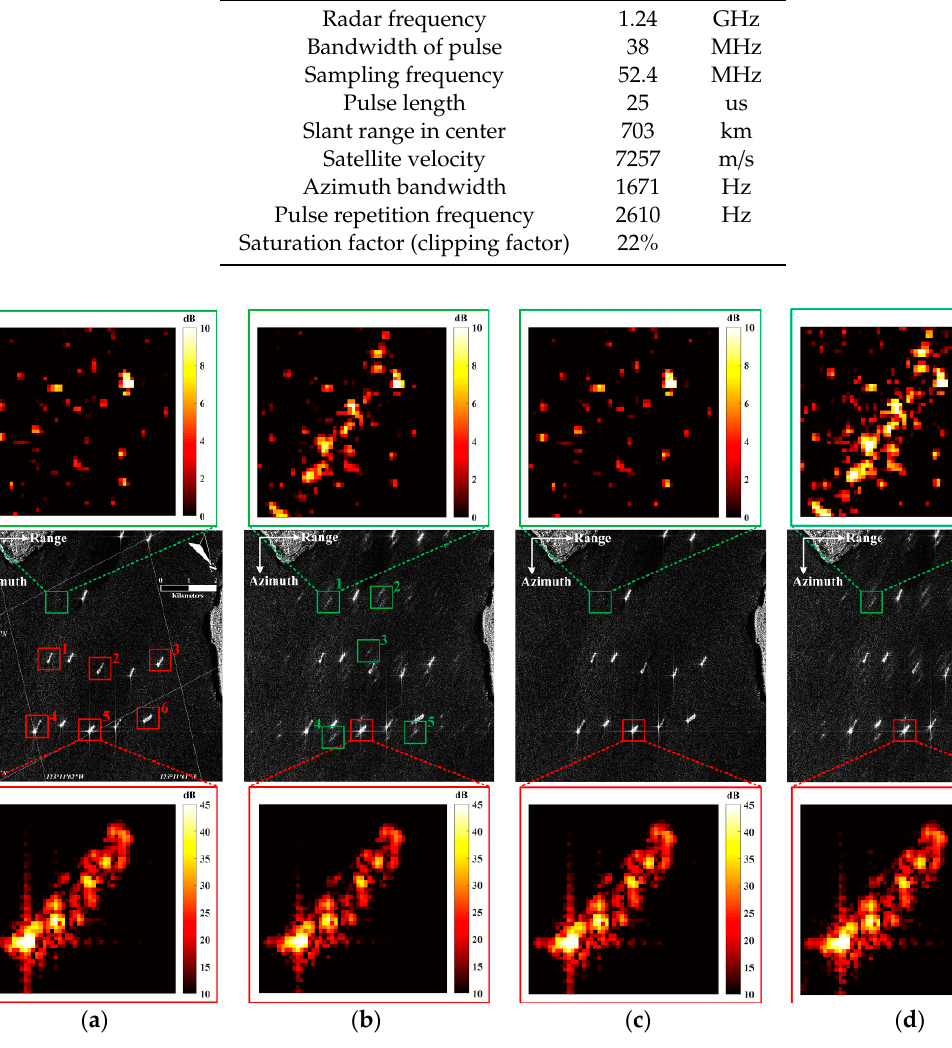
Figure 17. Simulation based on real focused data. The original image is from the Ultra-Fine (UF) mode of ALOS-2 (resolution 3 × 3 m), and the resolution of the simulated image is 6 × 6 m. ( a ) Non-saturated simulation image. ( b ) Saturated simulation image, in which there is a series of false targets, with a 22% saturated factor. ( c ) Reconstructed result with proposed method. ( d ) Reconstructed result using the power loss compensation (PLC factor 1.56).